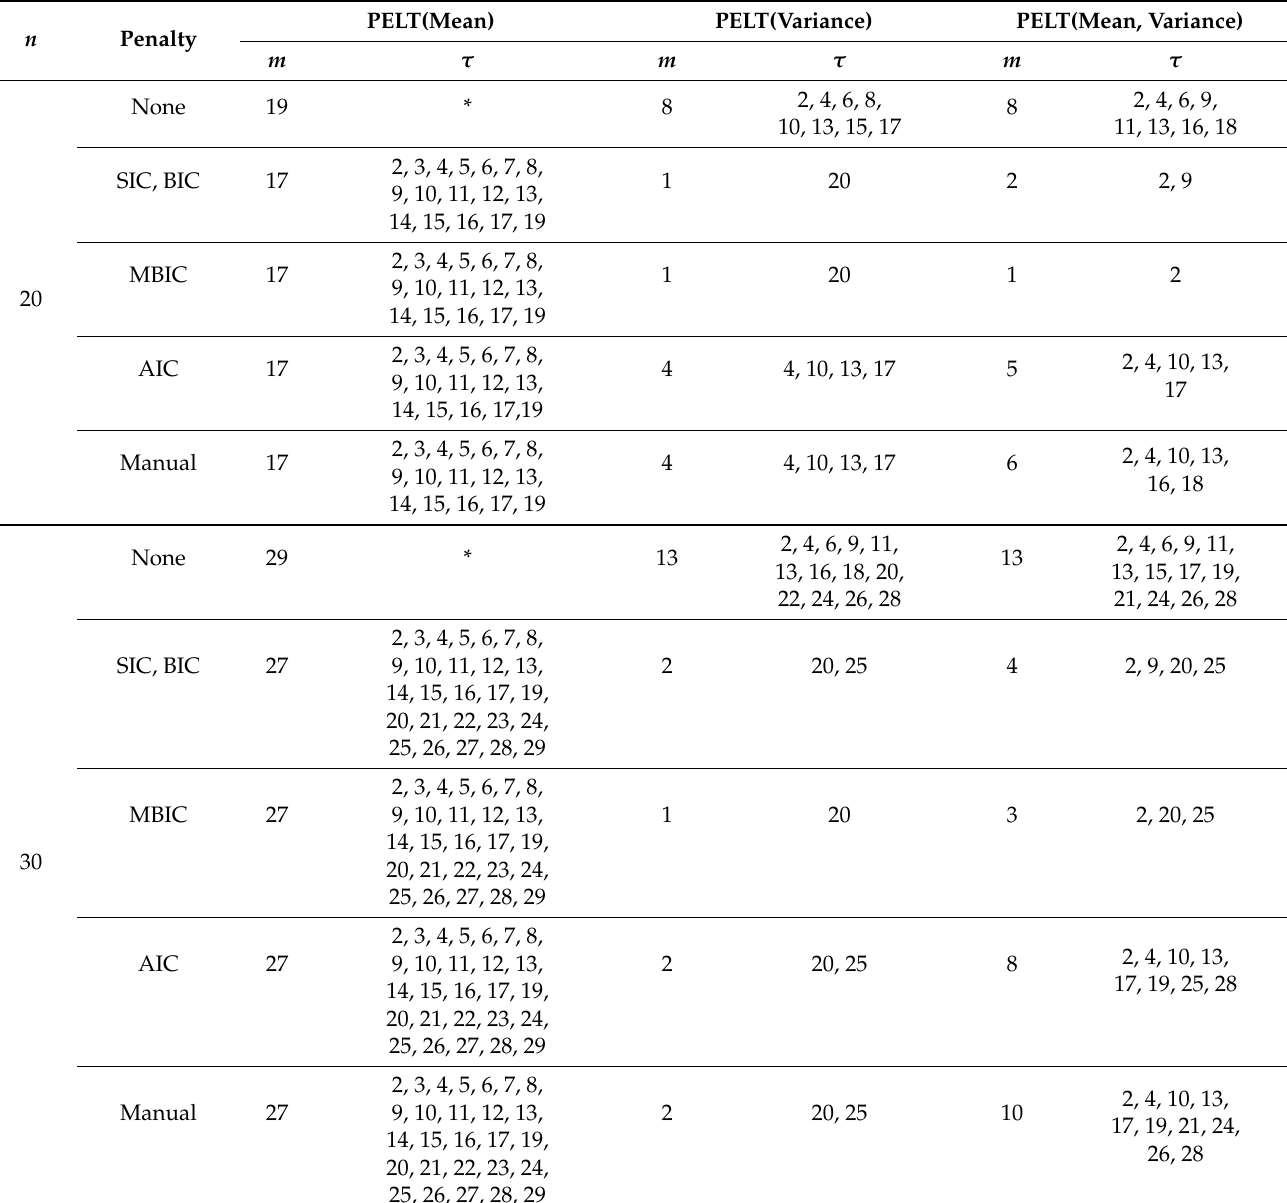
Table A3. PELT Algorithm Result for Simulated